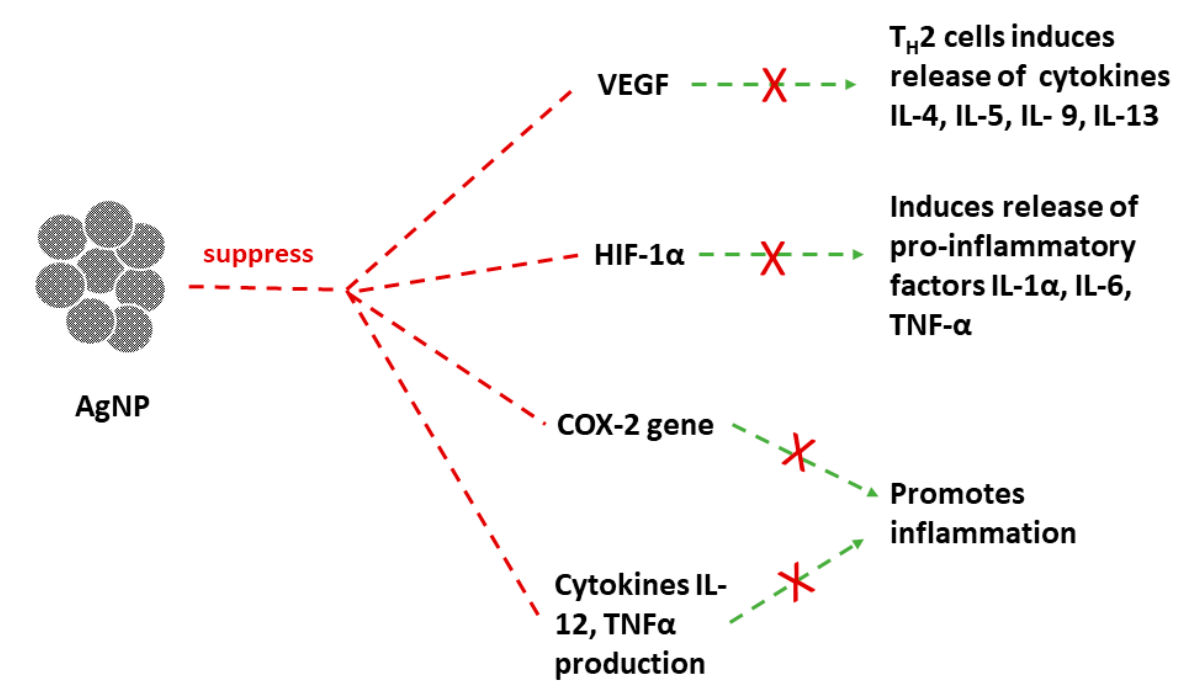
Figure 7. The figure depicts AgNPs mediated suppression of inflammatory agents such as vascular endothelial growth factor (VEGF), hypoxia-inducible factor-1 α (HIF-1 α ), cytokine production (IL- 12, TNF α ), and COX-2 expression. These mechanisms indicate AgNPs -mediated anti-inflammatory activity.